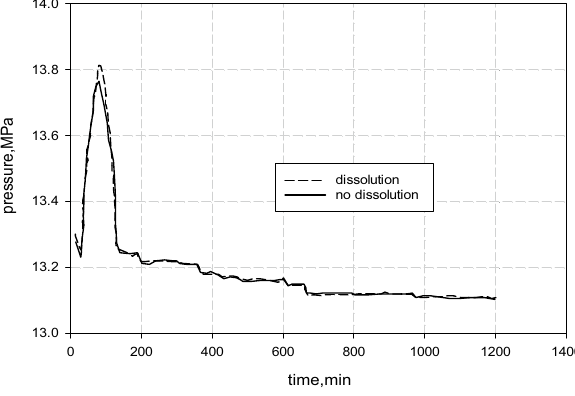
Fig. 13 Injection pressure curve contrasting dissolution and no disso- lution (experiment